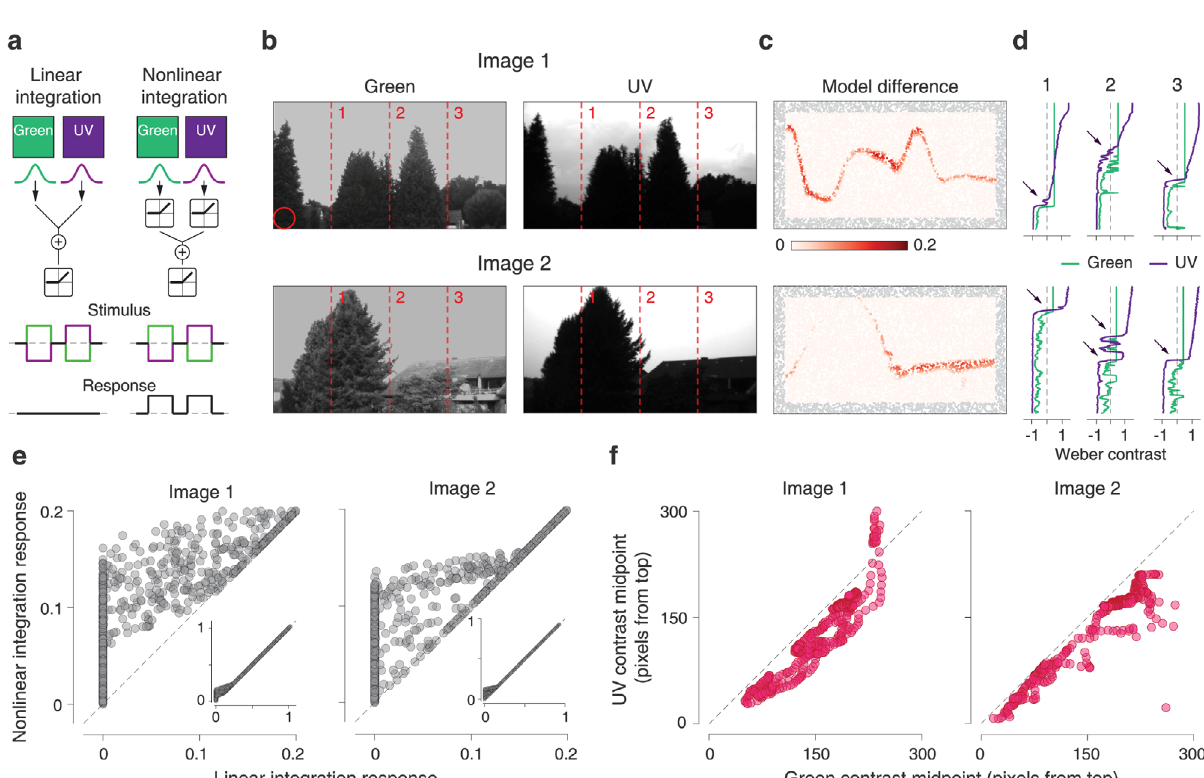
Fig. 10 Potential functions of chromatically nonlinear cells. a Schematic depiction of linear and nonlinear models of chromatic integration. b Examples of green (left) and UV (right) channels in natural images. The red circle shows the receptive fi eld size used in both models. c Heatmap of response differences from the two models (nonlinear model minus linear model) for 10,000 randomly selected patches of the images in b . Gray points show locations where the modeled receptive fi eld was partly outside the image range. d Contrast values for the UV and green channels along the three columns marked by the dashed lines in b . Arrows point towards regions of opposite contrast in the two color channels. e Comparison of the two model responses for low to moderate activation. The inset shows the same measurement over the entire activation range. f Comparison of midpoints for fi tted sigmoids to the contrast values of the green and UV channels along with all columns in the images of b